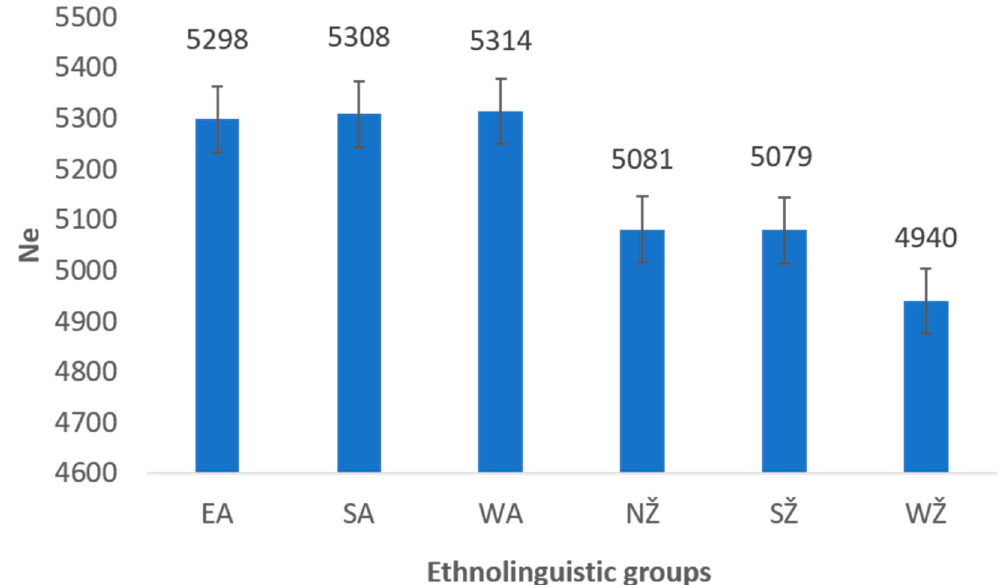
Figure 4. The harmonic mean of Ne estimated in the Lithuanian population ethnolinguistic regions. The error bars indicate 95% confidence intervals. EA—Eastern Aukštaitija, SA—Southern Aukštaitija, WA—Western Aukštaitija, NŽ—Northern Žemaitija, SŽ—Southern Žemaitija, WŽ—Western Žemaitija.